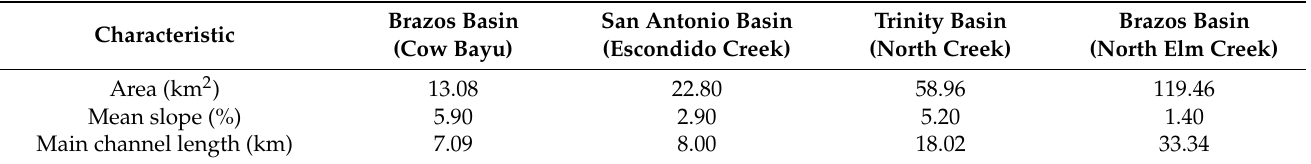
Table 1. Main hydrological characteristics of the four basins analysed in Case Study 1.